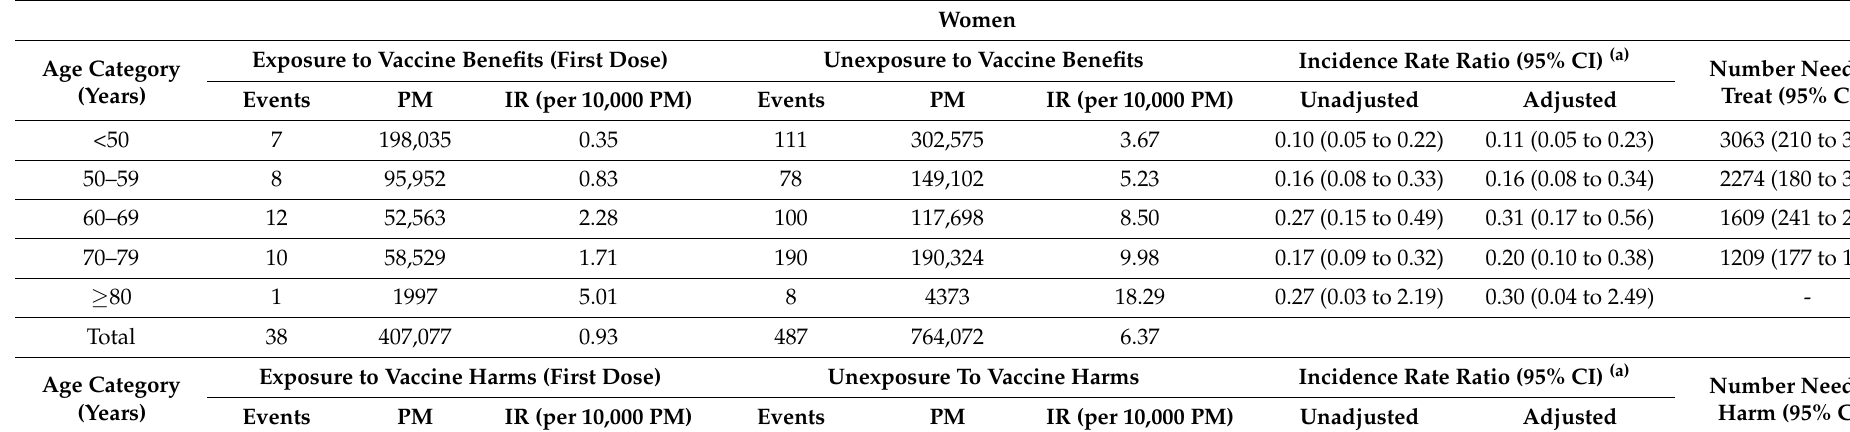
Table 2. Benefits—harms profile of Oxford-AstraZeneca vaccine (first dose) in women and men of five age categories.